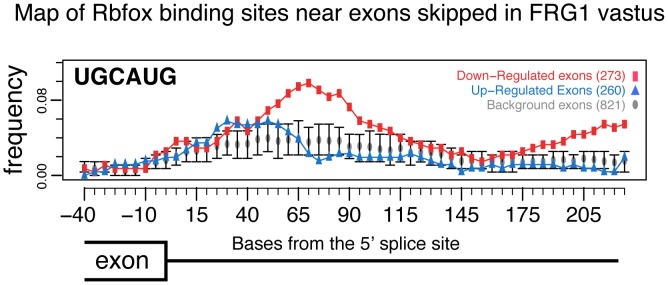
RNA map of Rbfox motifs downstream of exons.Each point represents the average frequency of UGCAUG in the 150 bp downstream of the 260 exons whose inclusion increases (blue triangles), the 273 exons whose inclusion decreases (red squares) or the 821 expressed alternative cassette exons whose splicing did not change in the comparison (gray circles, q>0.2 and |Sepscore|<0.3). Error bars indicate 95% confidence intervals of the mean frequency distribution for this population of background exons.